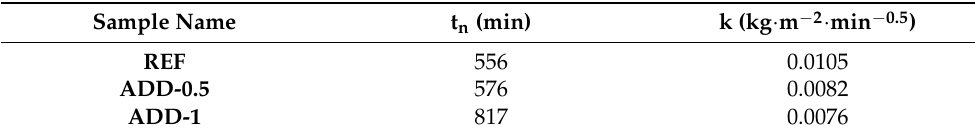
Table 3. Parameters estimated from water capillary absorption test: saturation time and water capillary absorption